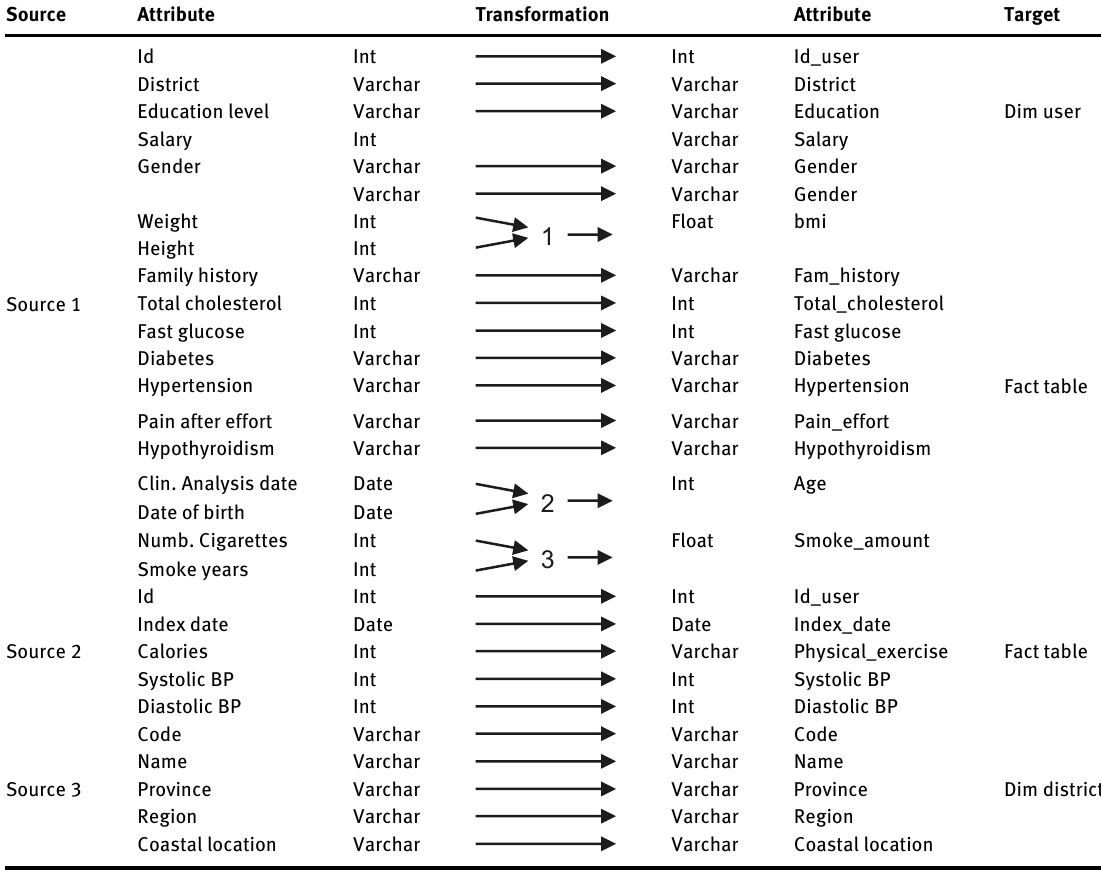
Table 6: Source to target mapping. Data from the various sources (left) and their transformations before being loaded into the target (right), in the Data Warehouse a